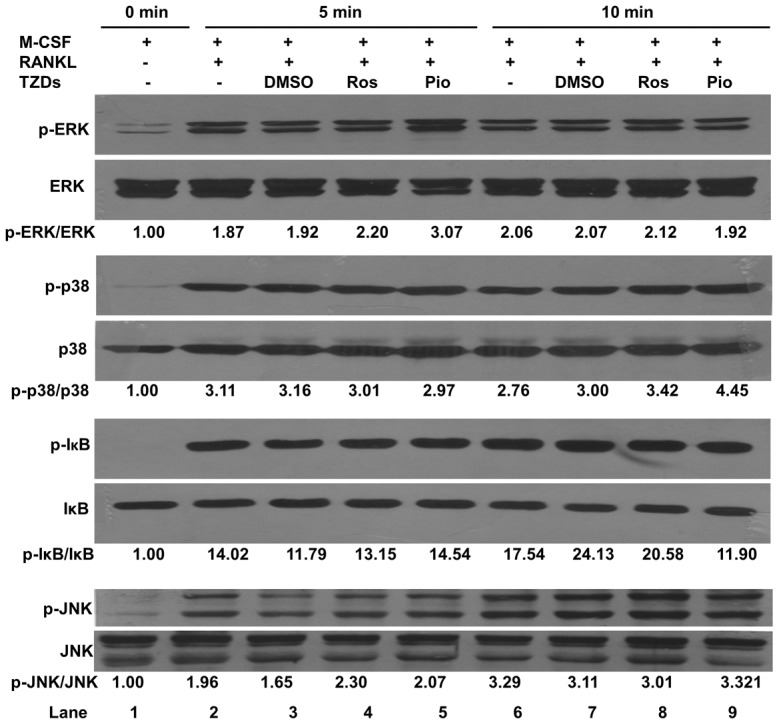
Rosiglitazone and pioglitazone exert no effects on RANKL-induced activation of the NF-κB, JNK, ERK and p38 pathways in BMMs.BMMs were cultured with M-CSF (44 ng/ml) to 20–30% confluence on 60-mm tissue culture dishes, and then treated with M-CSF (44 ng/ml) alone, M-CSF (44 ng/ml) and RANKL (100 ng/ml), M-CSF (44 ng/ml) and RANKL (100 ng/ml) plus vehicle (DMSO), 40 µM rosiglitazone (Ros) or pioglitazone (Pio) for 5 or 10 minutes (min). Activation of ERK, p38, NF-κB and JNK pathways was assessed as the level of the phosphorylated form of ERK, p38, IκB and JNK using Western analysis with antibodies against phospho-ERK, phospho-p38, phospho-IκB, and phospho-JNK, respectively. The blots were stripped and re-probed with antibodies against ERK, p38 and IκB for the expression levels of total proteins. Separate blots were probed with the antibody against JNK for the expression levels of the total JNK. Ratios of the phosphorylated form to the total protein for these signaling proteins were obtained by dividing the densitometric reading of the phosphorylated form with that of the total protein, and then the value calculated for 0 min was set as 1.00. All assays were repeated three times. One representative set of experiments is shown.